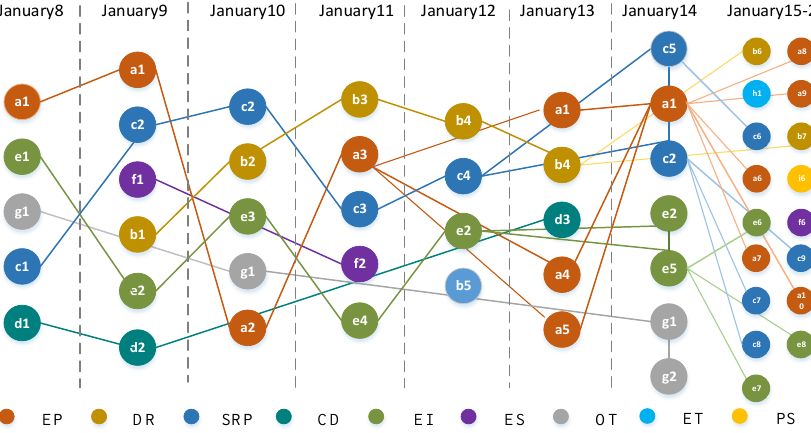
Figure 9. Graph of topic evolution over time (8 January 2020 – 21 January 2021).